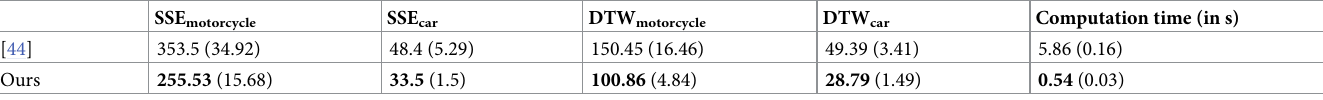
Table 13. Mean metrics computed for the Chua Boc site. In parenthesis, the standard deviation. SSE